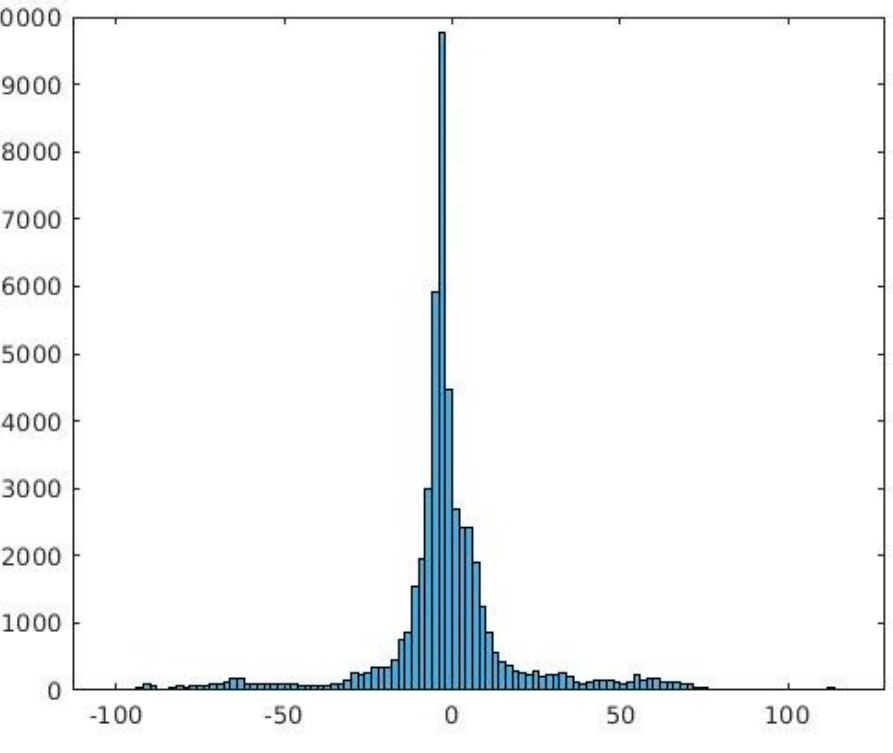
Figure 6. PC data